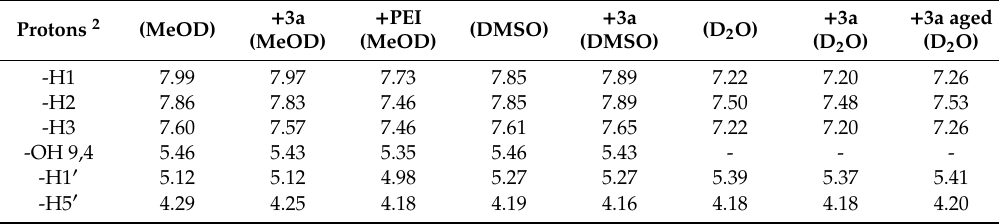
Table 2. 1 H-NMR ppm signals of Doxorubicin alone and mixed with 3a or PEI (solvent). Protons